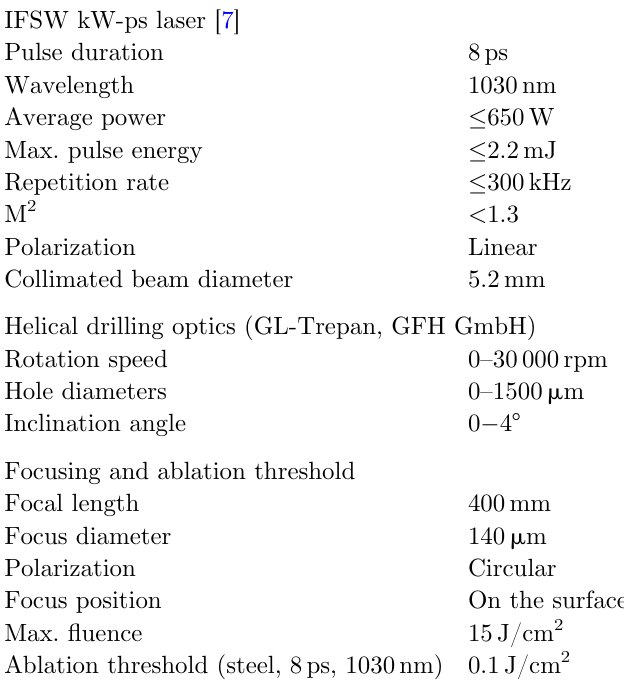
Table 2. Properties of the IFSW kW-class-ps laser system and the helical drilling